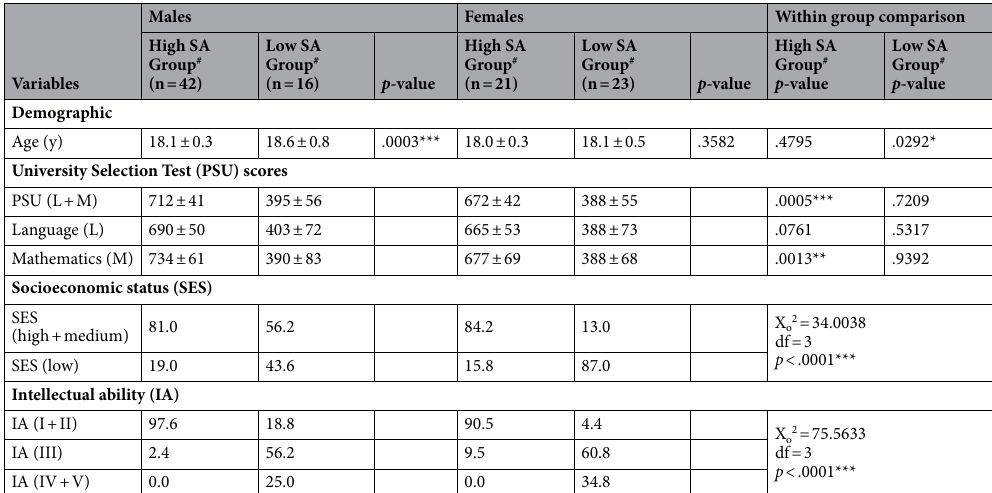
Table 1. Mean age, University Selection Test scores, socioeconomic and intellectual variables by group and sex. Data are expressed as mean ± SD, Means were compared by Bonferroni’s test; Data for SES are expressed in percentage of cases for SES categories and compared by Chi-square test. Data for IA are expressed in percentage of cases for IA categories and compared by Chi-square test. IA grades were pooled in two groups: I + II, and III + IV + V. IA grades: Grade I, superior; Grade II, above average; Grade III, average; Grade IV, below average; Grade V, intellectually deficient. p < .05 *; < .01**; < .001 *** # SA: scholastic achievement; High SA Group: High PSU score (> 620, > p75); Low SA Group: Low PSU score (< 450, <